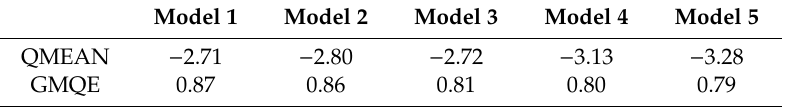
Table 1. QMEAN and GMQE scores of the models generated by the SWISS-MODEL tool. Figure 1. Three-dimensional (3D) structures of the h P-gp models selected. The models are presented in colors based on the QMEAN model quality values to allow instant visualisation of regions of the model that are well (blue) or poorly (orange) modeled: ( a ) Model generated by SWISS-MODEL tool; ( b ) model generated by I-TASSER tool; ( c ) model generated by Discovery Studio 4.1 Client/Modeler 9.12 tool.